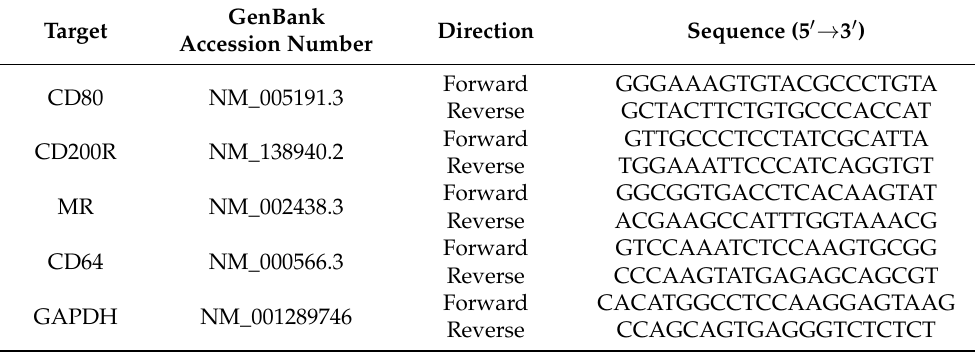
Table 1. Sequences of RT-PCR primers for gene expression